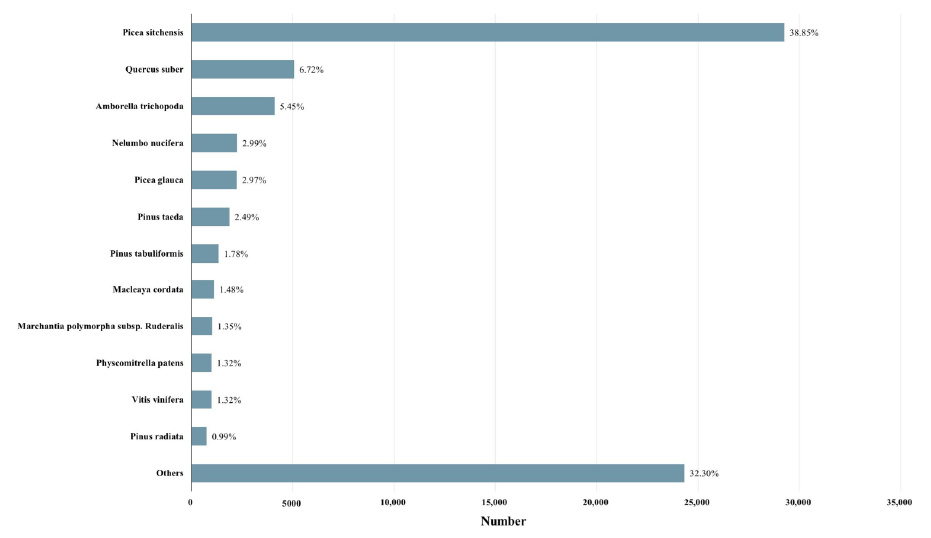
Figure 5. Species distribution of the top BLAST hits for each unigene of P. koraiensis under different supplementary lights in Nr.